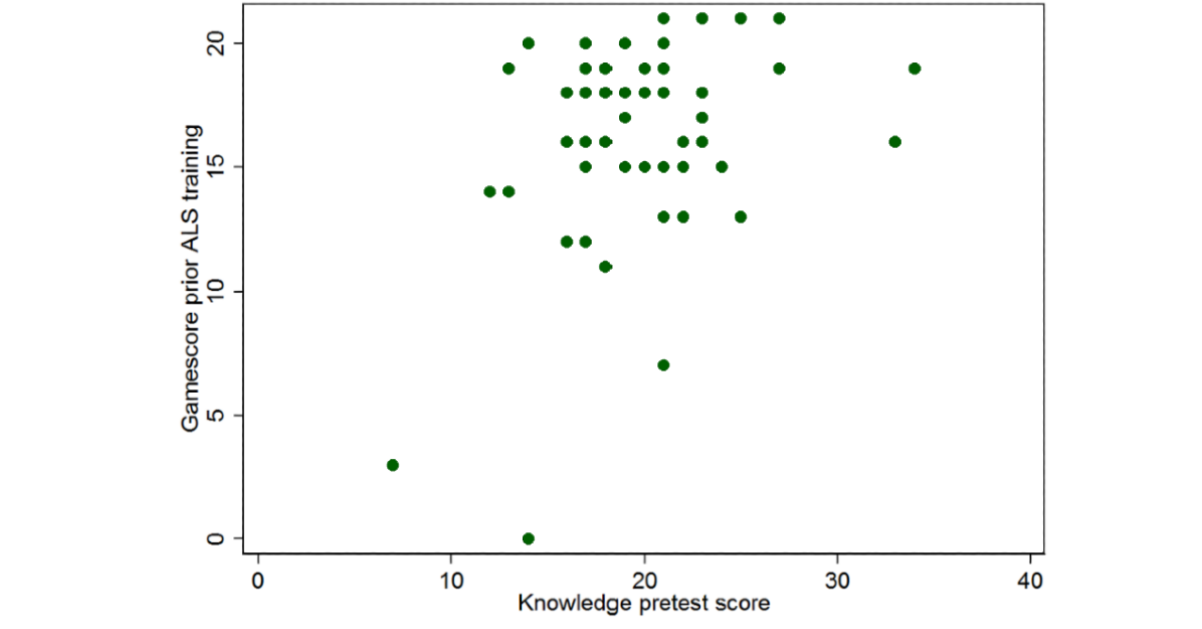
Figure 3. Correlation between game score before Advanced Life Support training and knowledge pretest score was low ( P =.01, r=.37).